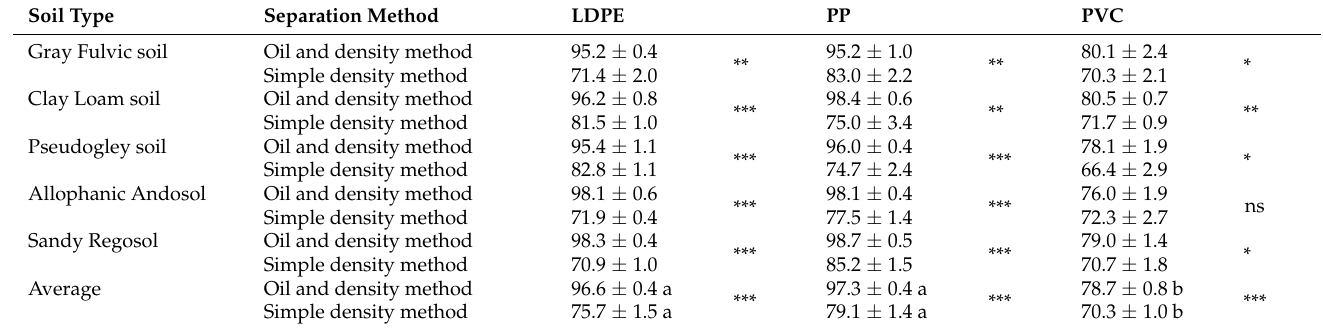
Table 5. Comparison of the recovery rates of the small plastic plastics (<1 mm) from the five soils between the oil and density separation method using a mixture of canola oil and NaCl solution and the simple density separation method using saturated NaCl